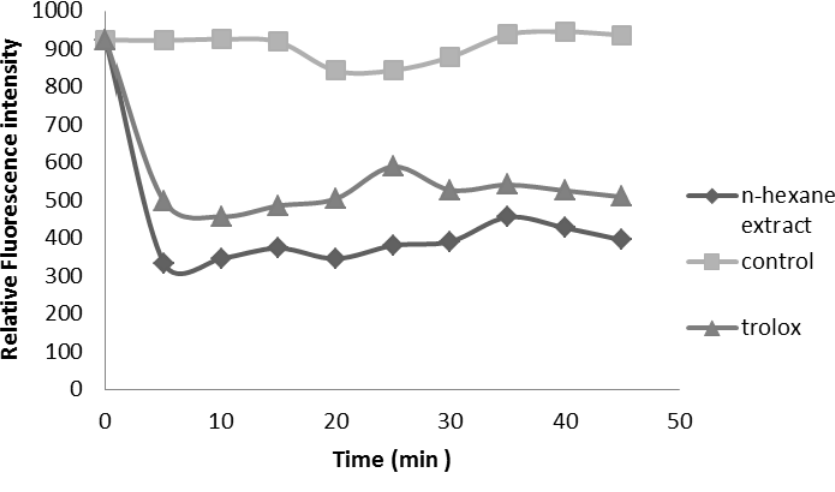
Figure 3. Illustration of calculation the ORAC value expressed as the net area under the curve